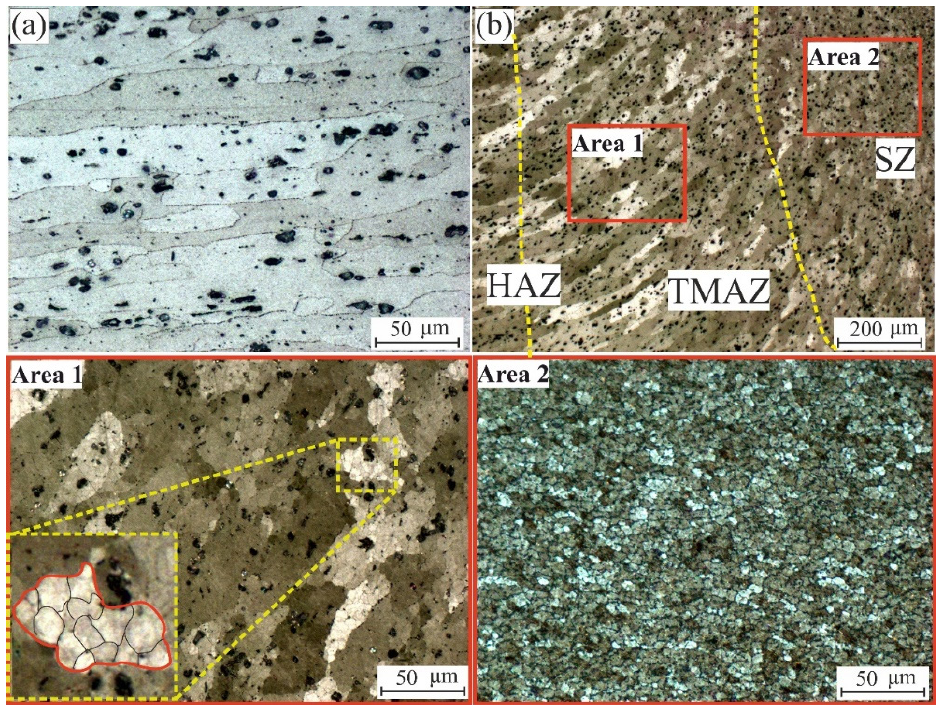
Figure 4. The typical microstructure image ( a ) as-received Al 2024 alloy sheets and ( b ) the friction stir processed zones.